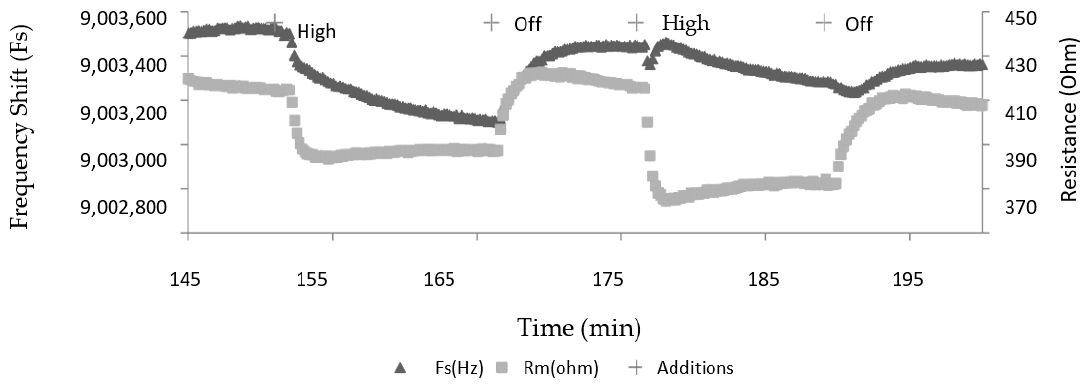
Figure 3. Changes in Fs and Rm after exposure of retinal tissue deposited on a TSM Au electrode under high light intensity condition.